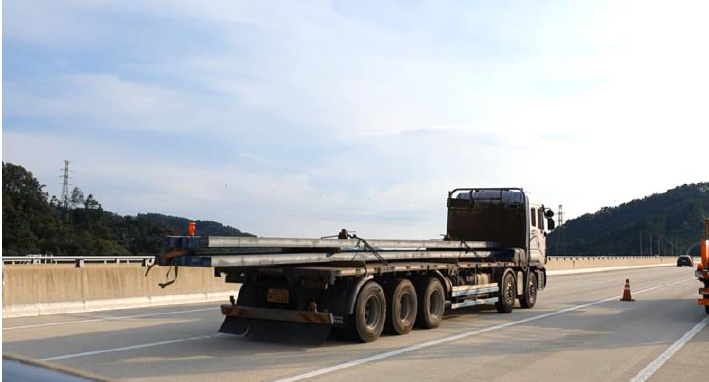
Figure 16. Five-wheel heavy truck crossing the Geumgok Bridge.